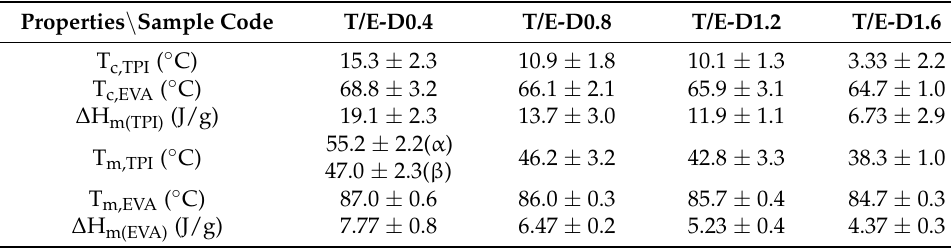
Table 2. Tc, Tm of TPI/EVA composites with different DCP contents. Properties \ Sample